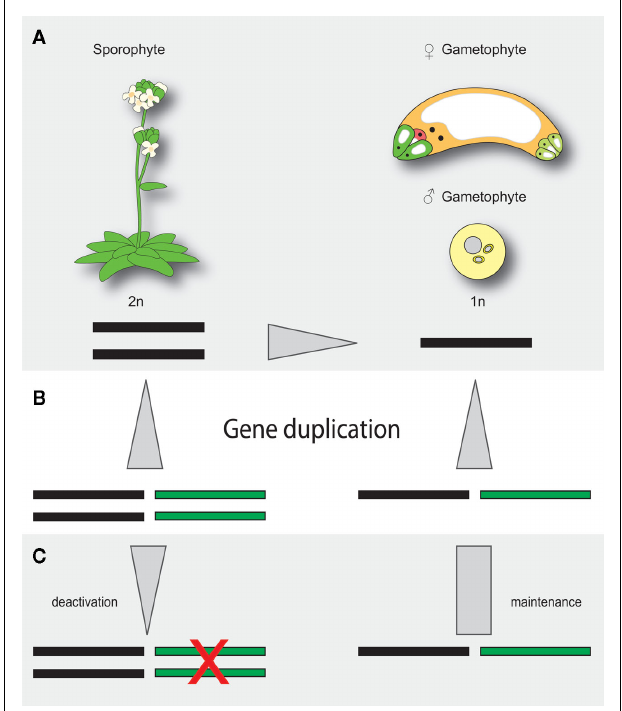
FIGURE 1 | Hypothetical model of life phase dependent redundancy adjustment. (A) The diploid sporophyte and the haploid gametophytes exhibit, by definition, different redundancies for a given locus. Deleterious mutations are consequently masked in the sporophyte but dominantly expressed in the gametophyte. (B) Gene duplication increases redundancy levels in the haploid and diploid phase. (C) If the activity of a given gene is preferentially maintained in the gametophyte, different redundancy levels between the sporophyte and the gametophytic life phase might be buffered. Black bar, ancient locus; green bar, duplicated locus, gray arrows indicate redundancy differences.